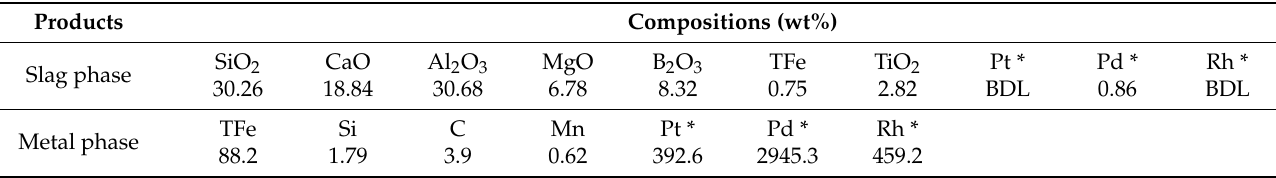
Table 2. The compositions of slag and metal phases generated from the confirmation